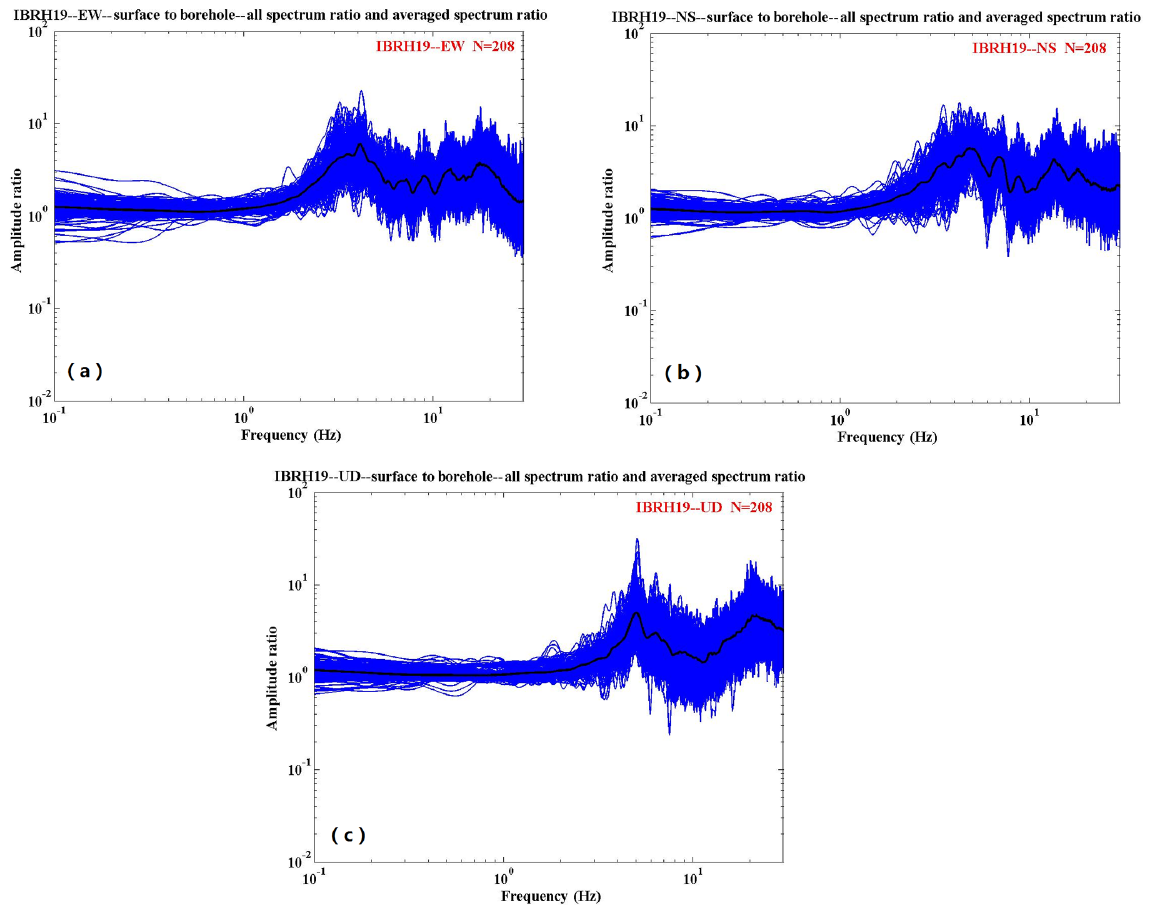
Figure 4. Surface-to-borehole spectral ratios at IBRH19: (a) EW2 / EW1, (b) NS2 / NS1, and (c) UD2 / UD1. The blue lines stand for the spectra ratio for every earthquake event, and the black line stands for the average spectra ratio for all the events. Table 1. Information for M 4 . 5 earthquake (IBRH100911211539). PGA (gal) PGA amp. I jma Boh. Surf. Amp. (surf. / boh.) Boh. Surface Difference (surf. − boh.) Res. (sim. − obs.) Sim. Obs. Obs. Sim. Obs.